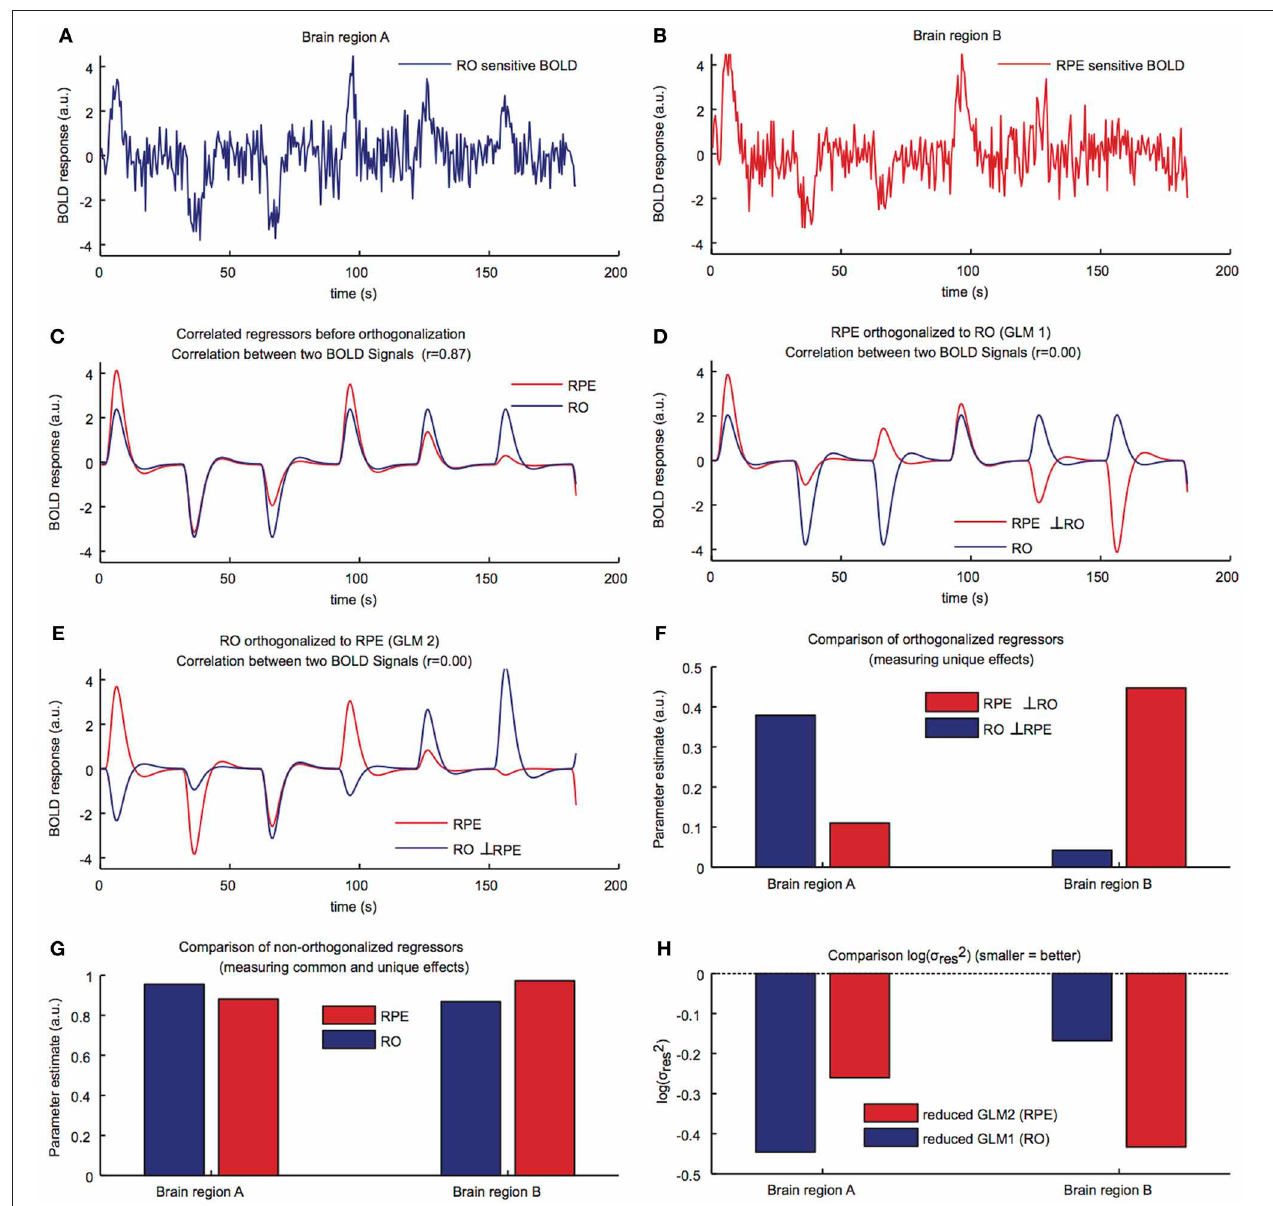
FIGURE 2 | (A,B) A simulated BOLD signal was created for a total of 200s for two brain regions representing mainly the RPE and the RO, respectively. Zero second duration events were used. (C) Correlation between the RO and the RPE regressor if there is no orthogonalization between the regressors ( r = 0 . 89). (D) The RPE regressor is orthogonalized based on the RO regressor ( r = 0). (E) The RO regressor is orthogonalized based on the RPE regressor ( r = 0). (F) Parameter estimates of the non-orthogonalized